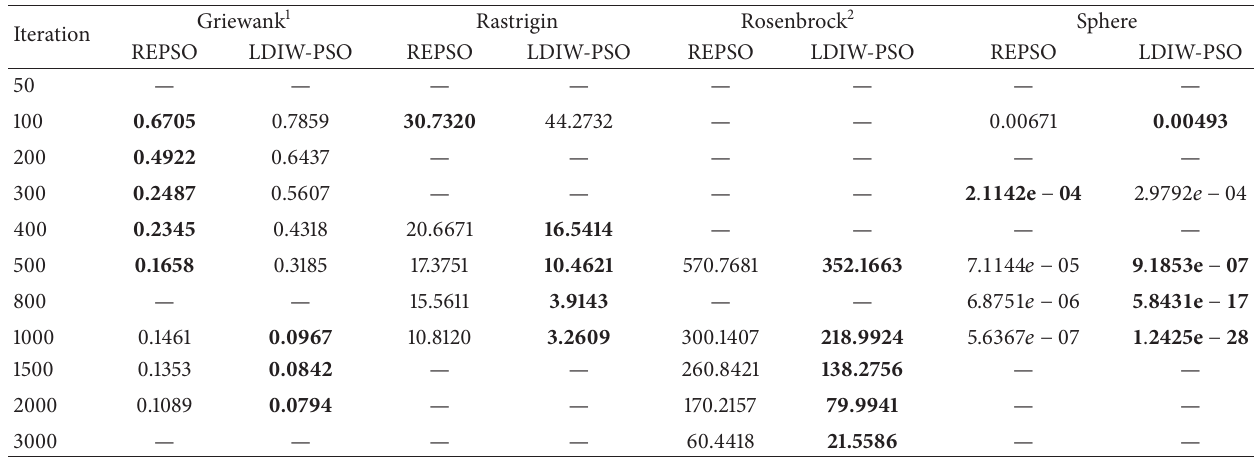
Table 5: Experimental results for LDIW-PSO compared with